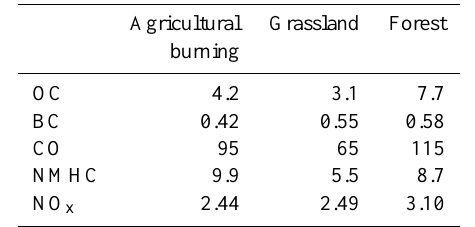
Table 2. Biomass burning emission factors ( β , gkg − 1 ) specified in the emission model (see Eq. 3) for different types of vegetative land cover. The data are based on Andreae and Merlet (2001) and subsequent updates.